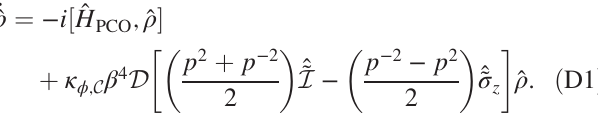
a phase-flip error is estimated by initializing the PCO to the state jþi and estimating h − j ˆ ρ PCO j − i . For clarity, (c) and (d) show the and (b),